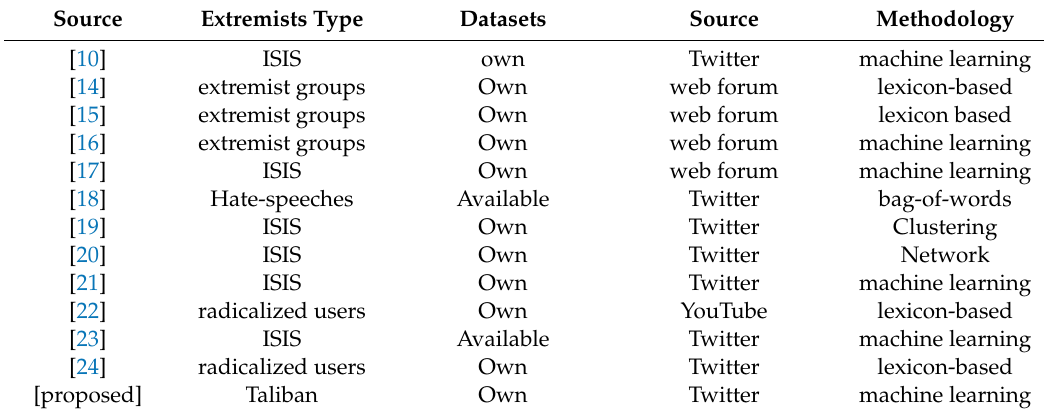
Table 1. Previous work on radicalization